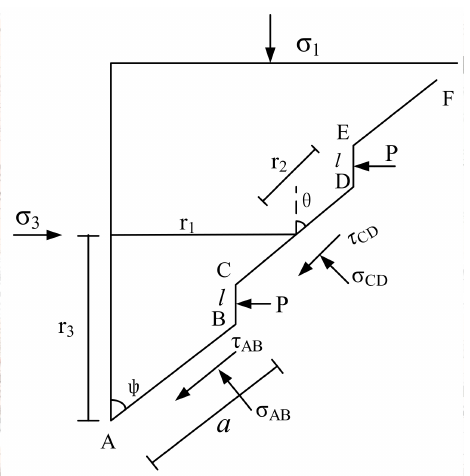
Figure 4. Tension-shear combined failure characteristics of rock